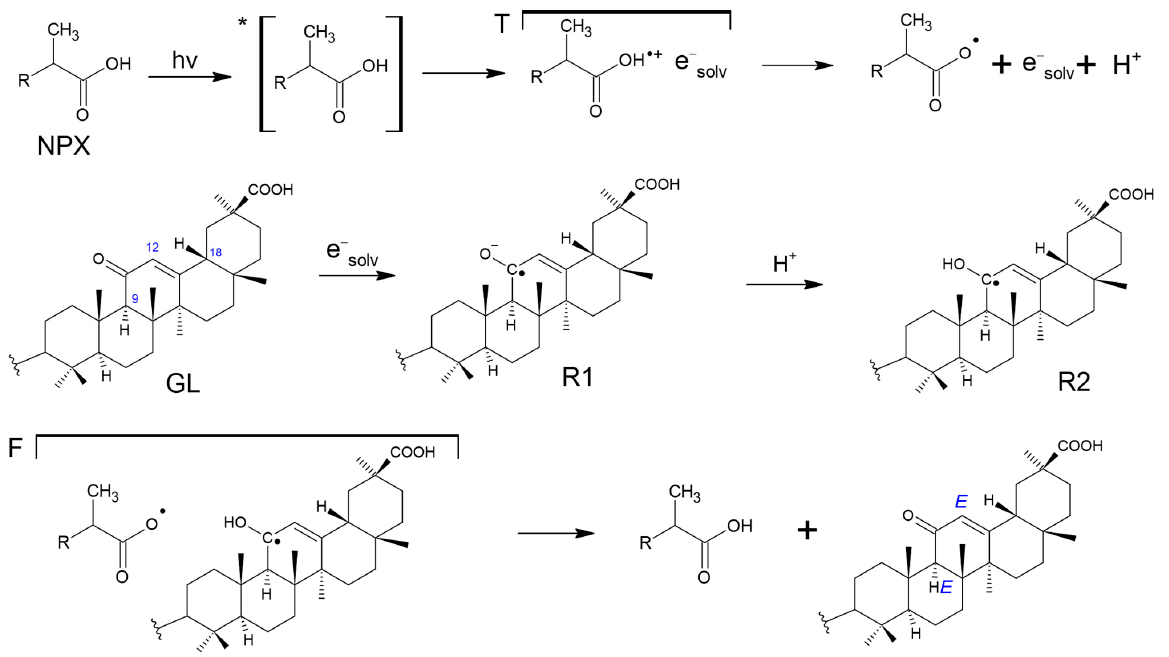
Scheme 2. The formation of GL radical anion (R1) and its further transformation into R2 during